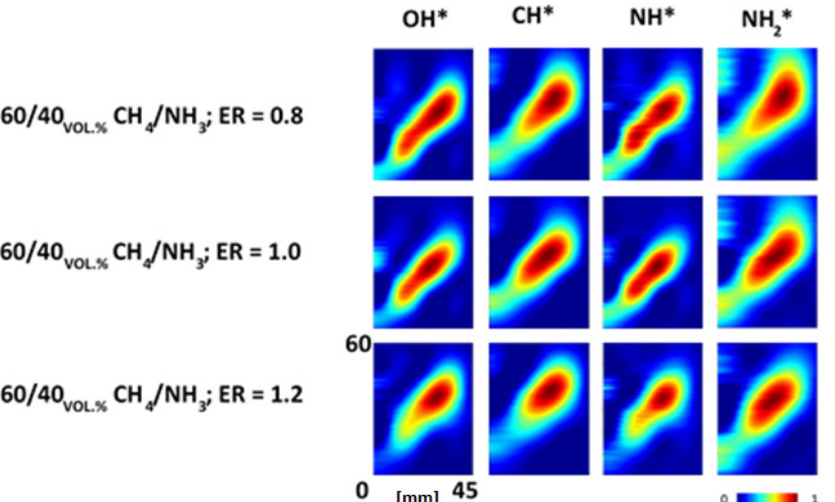
Figure 5. Chemiluminescence analysis for the 60/40 case at various equivalence ratios. Colormap normalized to image dataset max. Similar to this case, other conditions were also obtained with varied results across species.